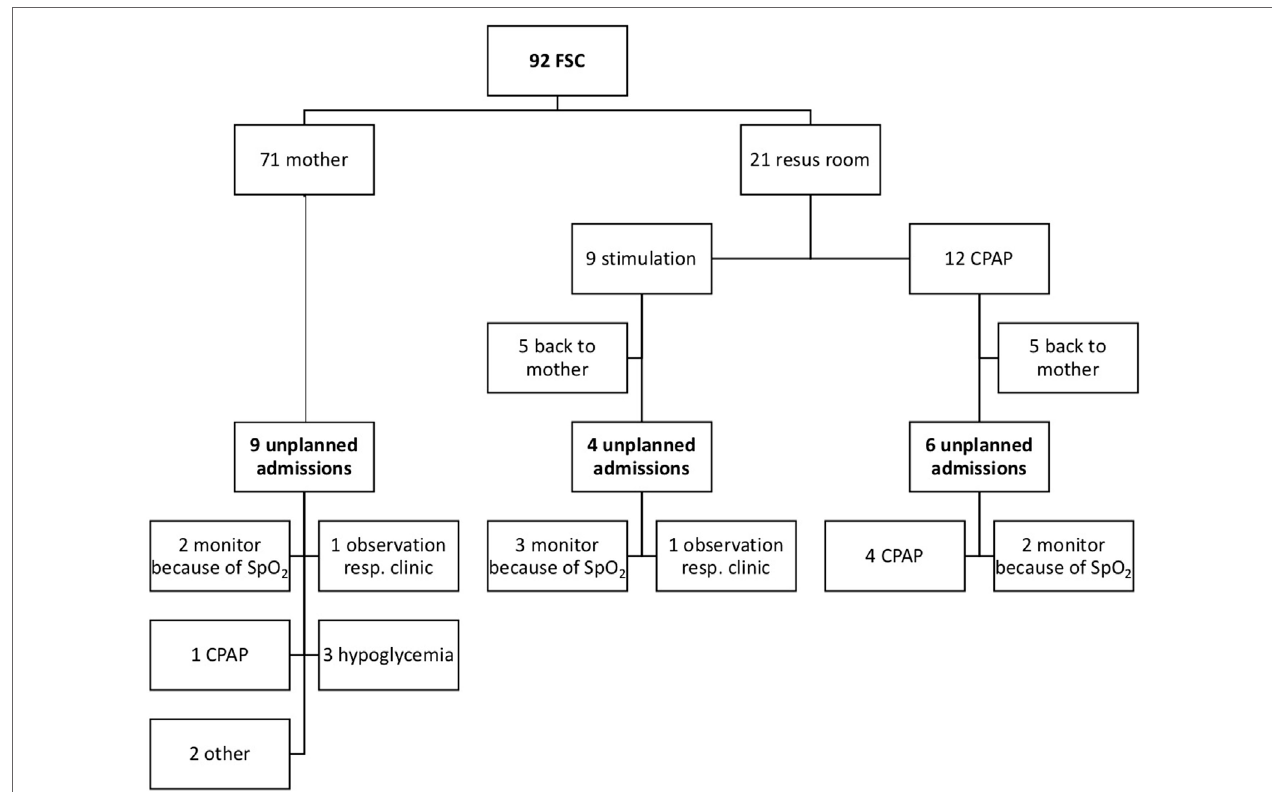
FigUre 1 | Overview of neonatal outcome after family centered-caesarean section (FCS). A flowchart of the neonatal outcome after FCS is shown. Resus room, resuscitation room; Resp clinic, clinical symptoms of respiratory